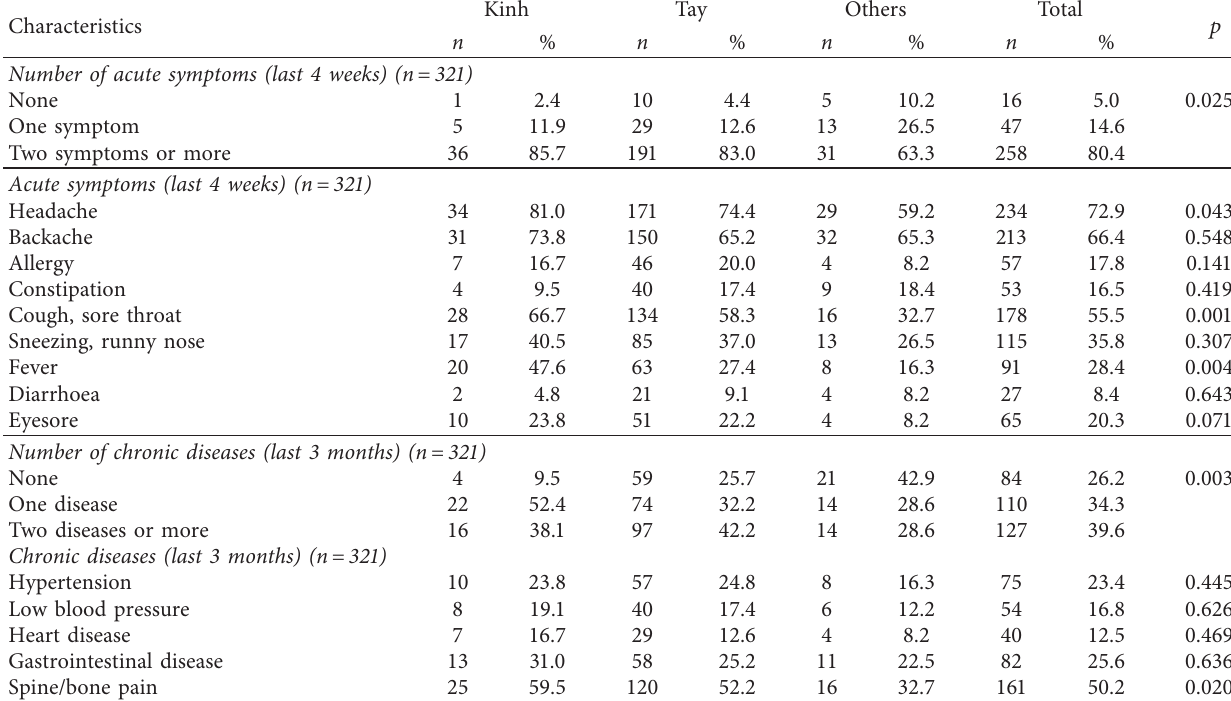
Table 2: Health characteristics by ethnic